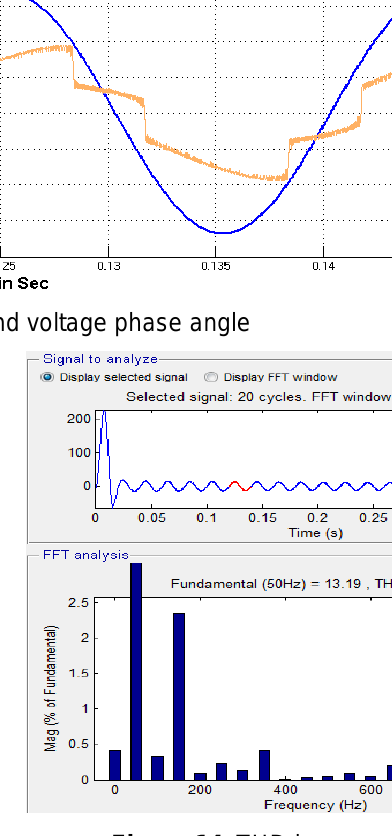
Figure 14. THD in source